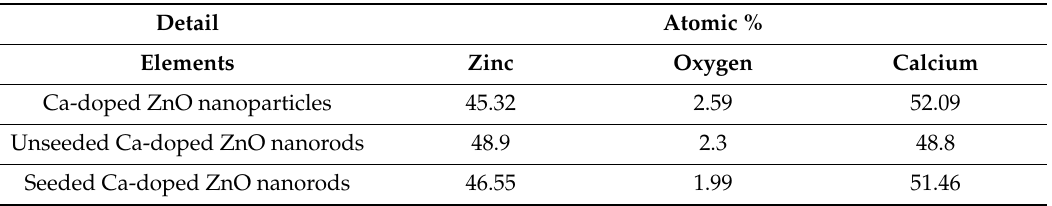
Table 3. Atomic percentage of Zn, O, and Ca present in the prepared photoanodes .